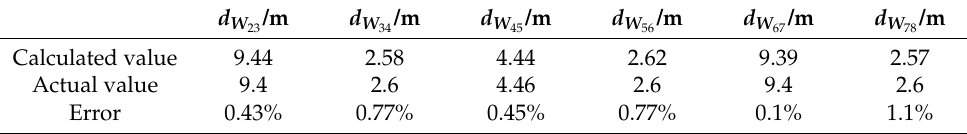
Table 2. The calculation results of wave peaks spacing after velocity correction.